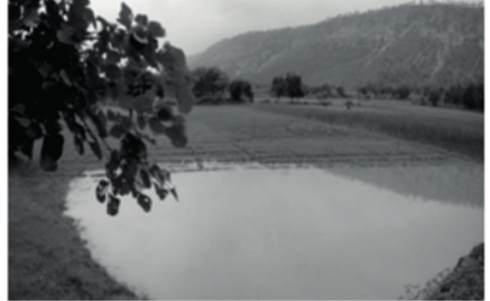
Fig. 4 Rainwater harvesting structure johads.